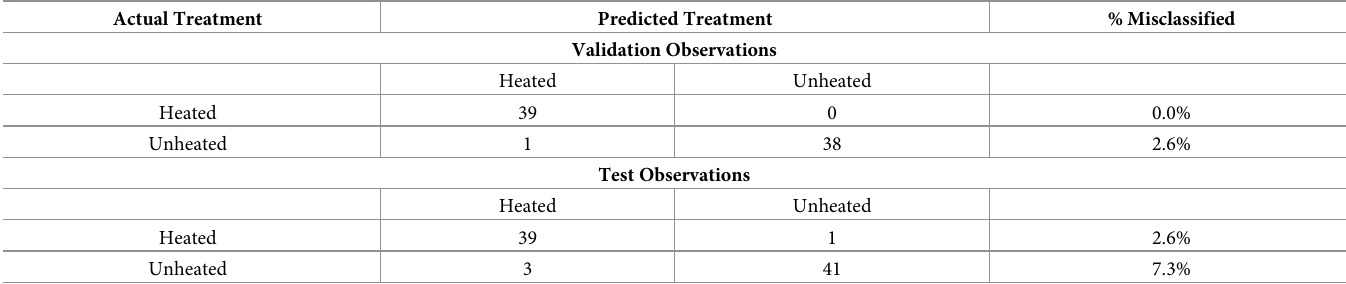
Table 5. k-NN model A observation-level prediction results.